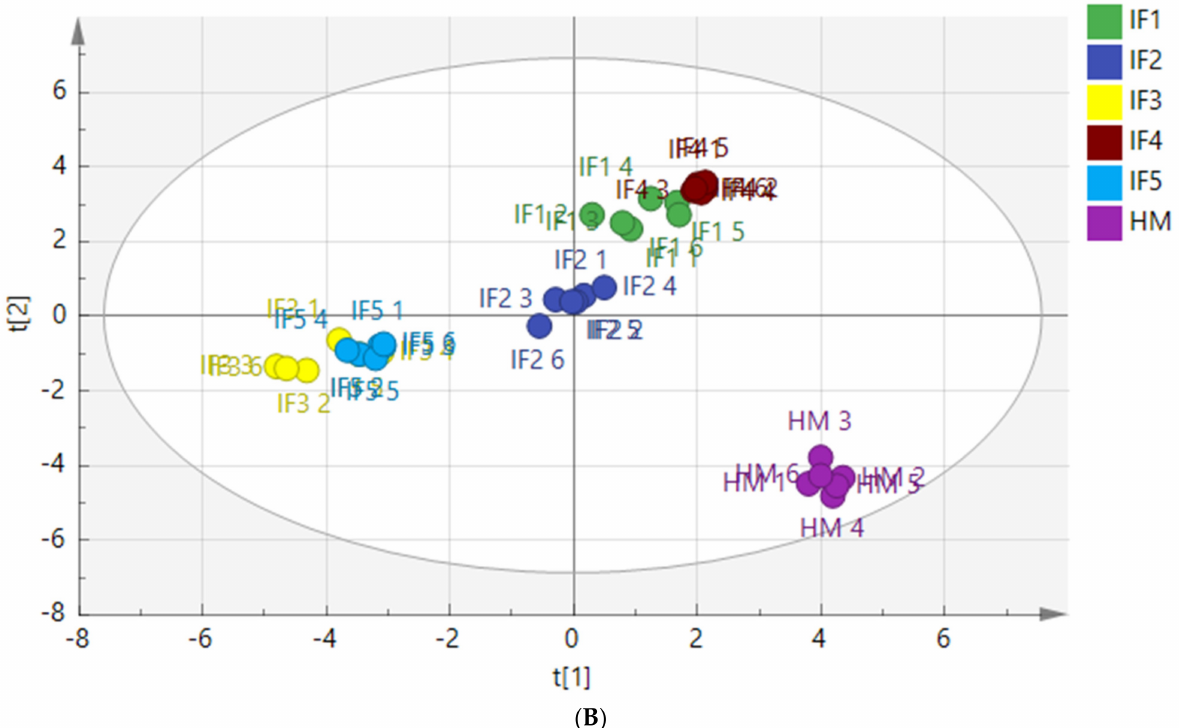
Figure 4. PLS-DA model score chart of fatty acids in infant formulas and human milk after gas- tric digestion ( A ) and intestinal digestion ( B ). IF1: vegetable oil-based formula; IF2: vegetable oil-based formula with MFGM; IF3: bovine milk/vegetable oil-based formula with cream; IF4 bovine milk/vegetable oil-based formula with cream and soybean phospholipid; IF5: whole fat milk power/vegetable oil-based